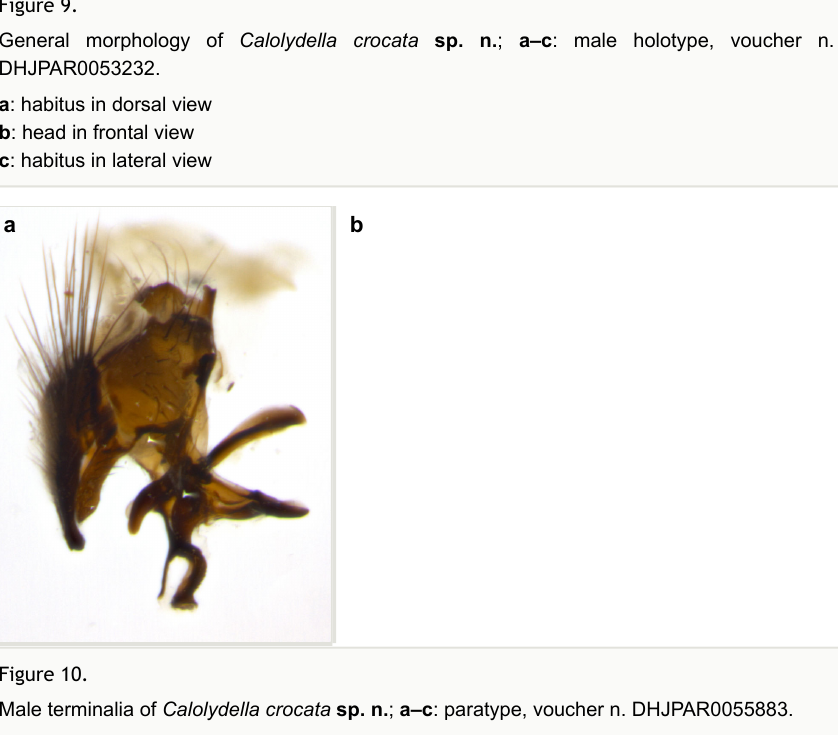
General morphology of Calolydella crocata sp. n. ; a–c : male holotype, voucher n.